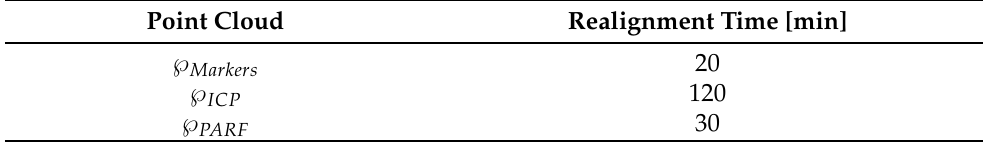
Table 9. Approximated realignment time for the four different